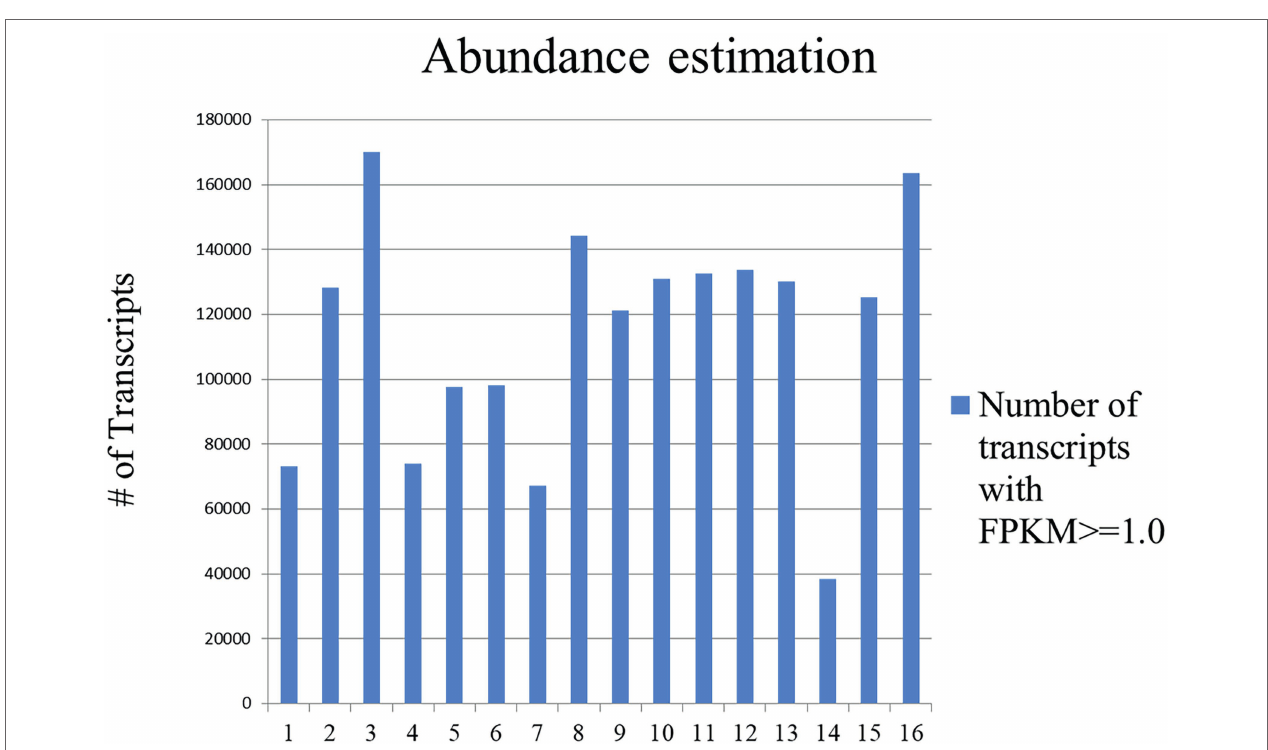
FIGURE 4 | Graphical representations of DEGs with FPKM value ≥ 1 of 16 libraries prepared in control and treated sample at four different developmental stages. Samples contained 1,696,570 transcripts and ~ 62.48–95.39% (average ~ 83.79%) of reads